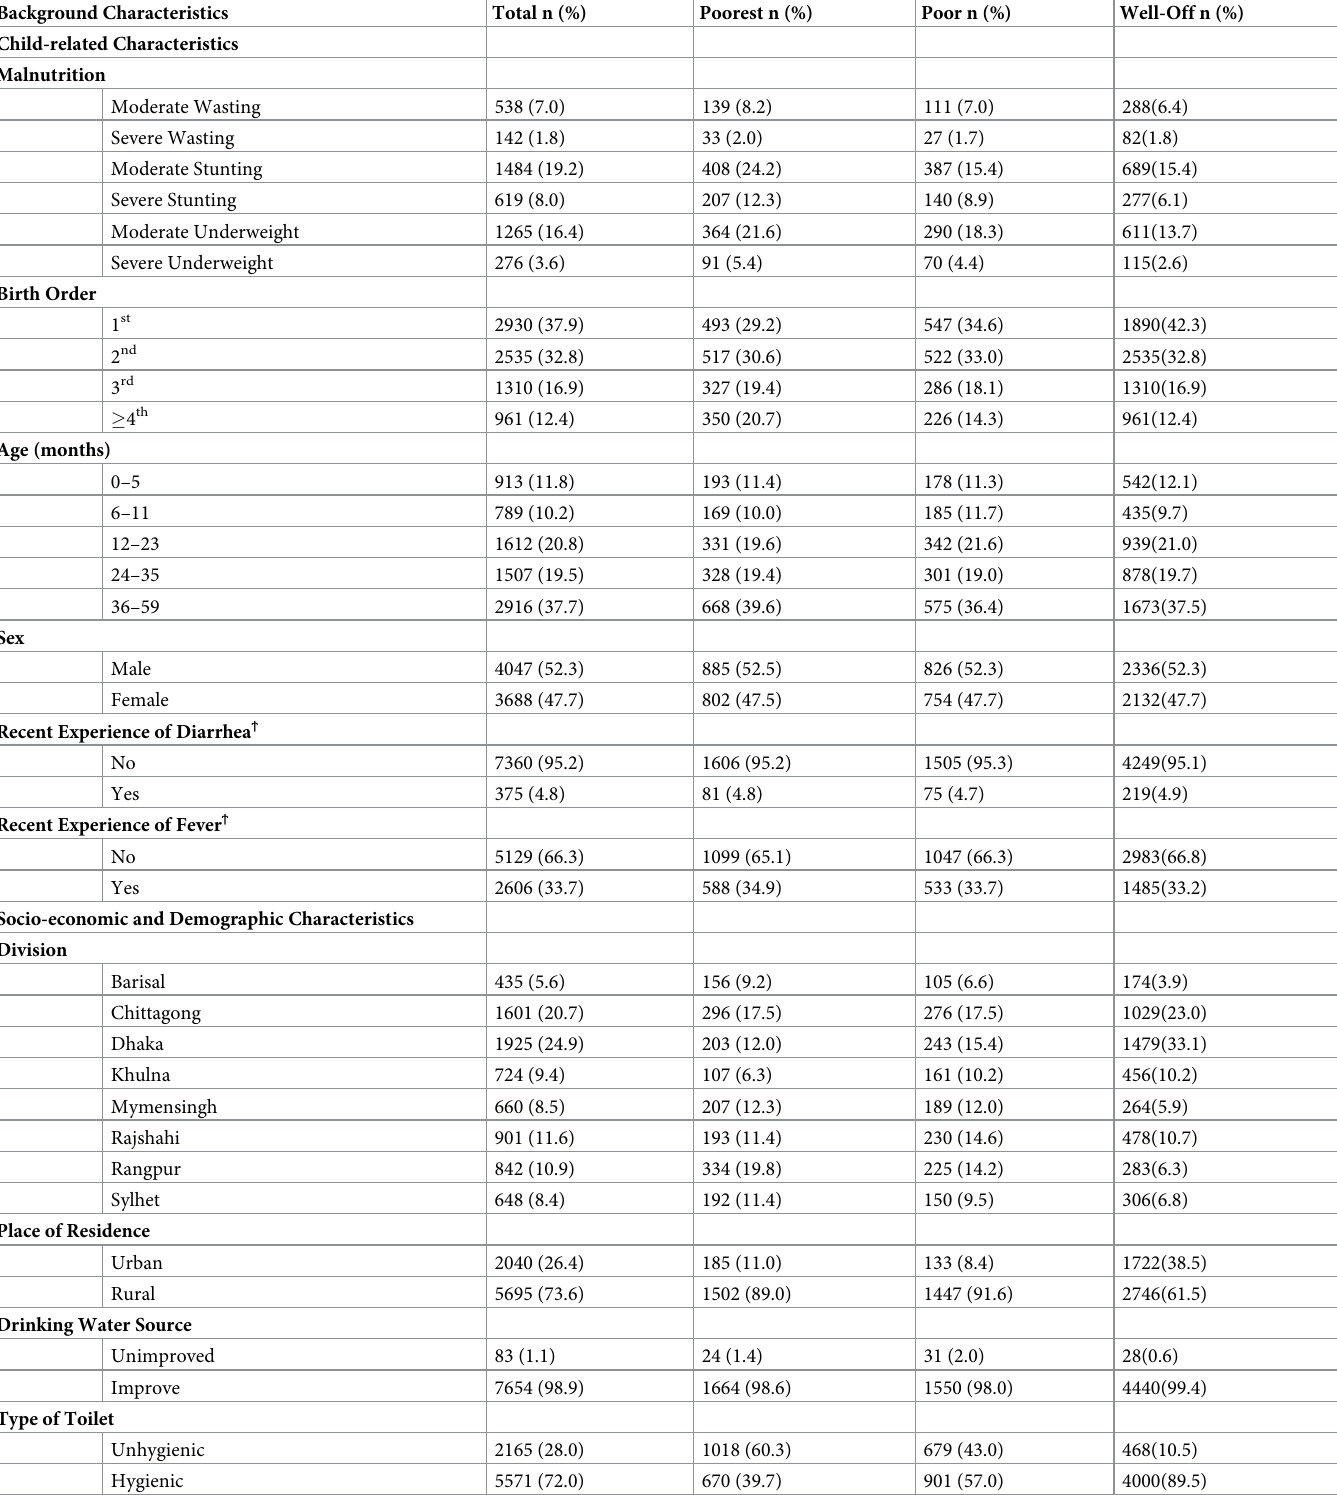
Table 1. Frequency distribution of background characteristics for study participants (n =